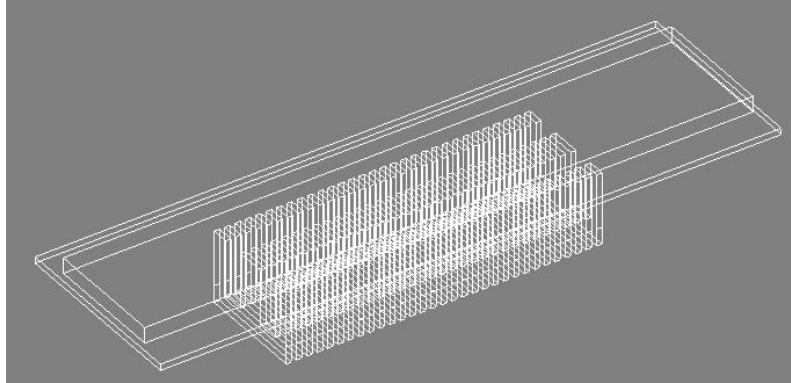
Figure 3. Three-dimensional view of model 1.